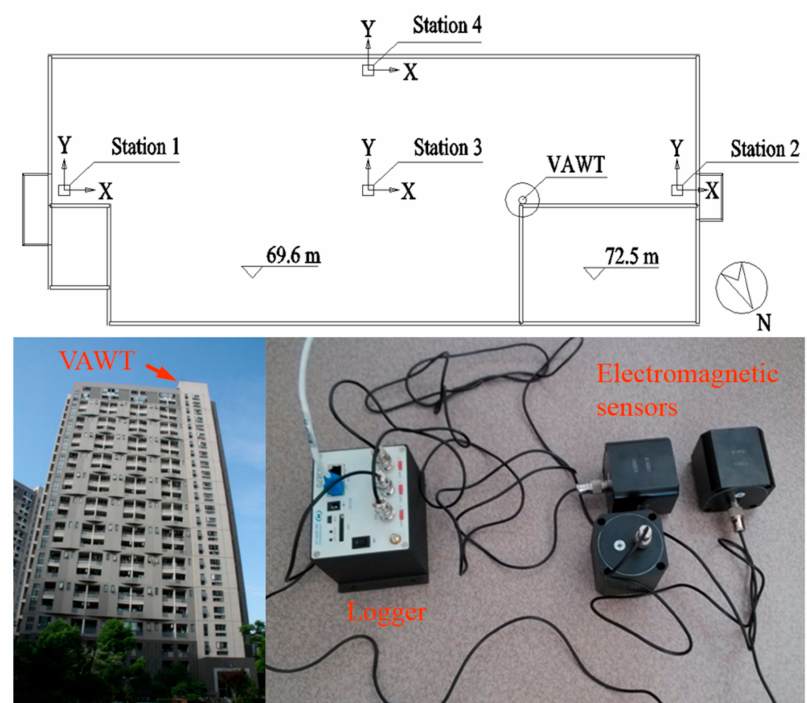
Figure 1. Sensor deployment on the #6 building’s roof.